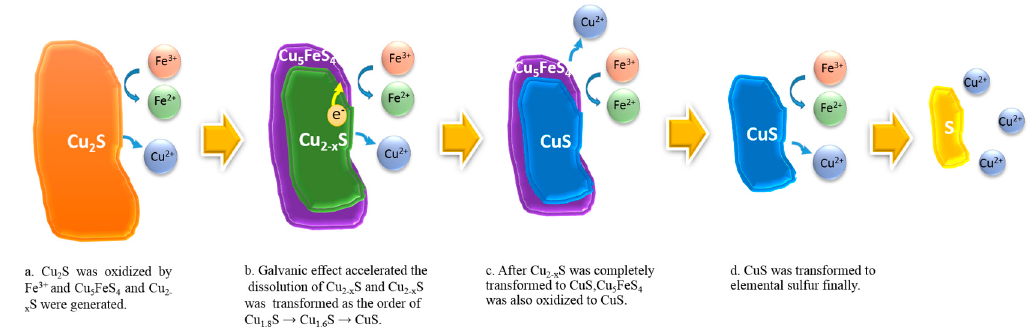
Figure 5. Probable fine phase transformation during chalcocite acidic ferric sulfate leaching.